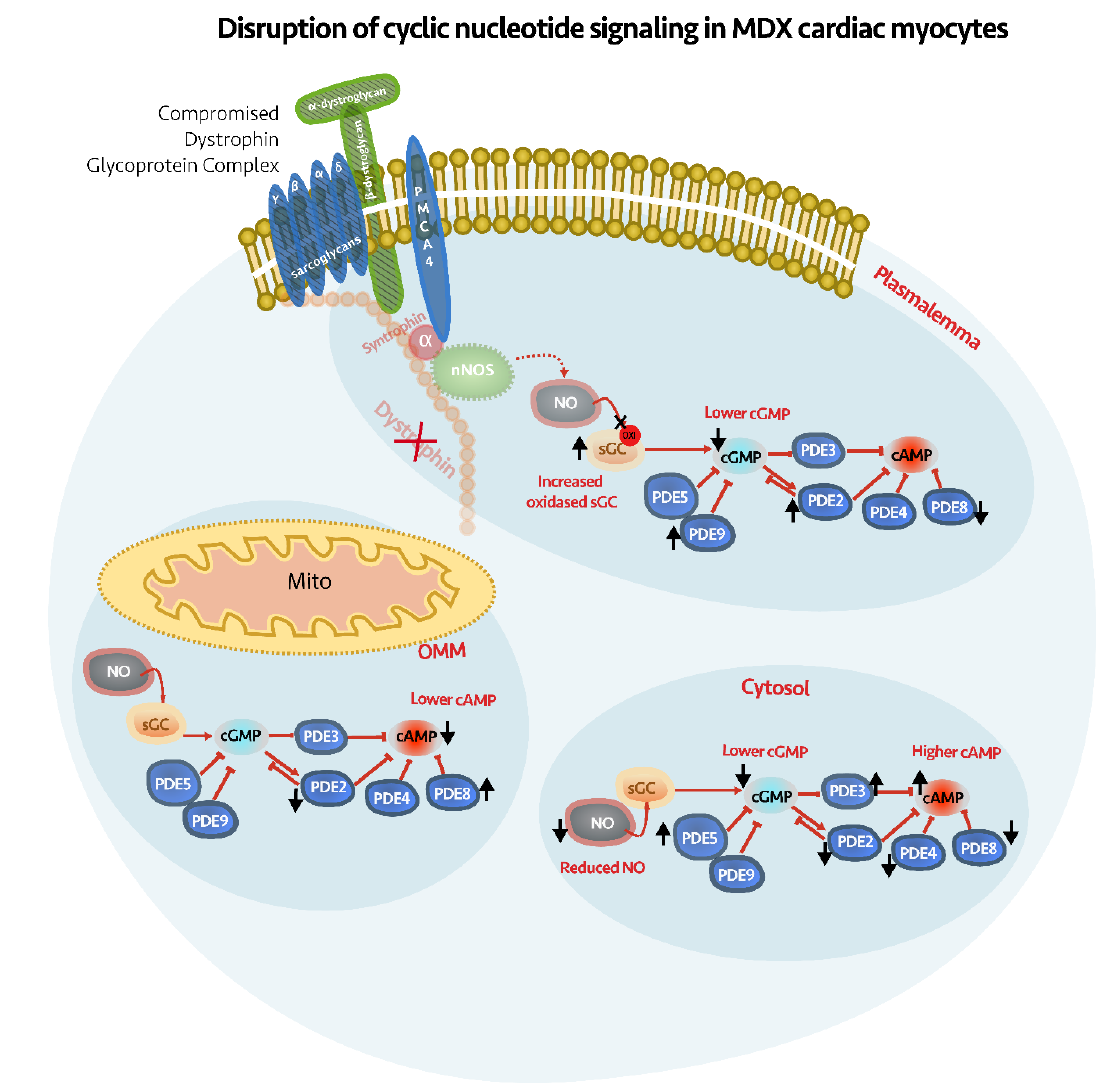
Figure 7. Schematic illustration of how basal cGMP and cAMP levels are affected at the plasmalemma, OMM and cytosol of NVM from mdx mice. Black arrows indicate changes that occur in the activity of PDEs, NO levels or amount of oxidised sGC in the dystrophic cells compared to controls.